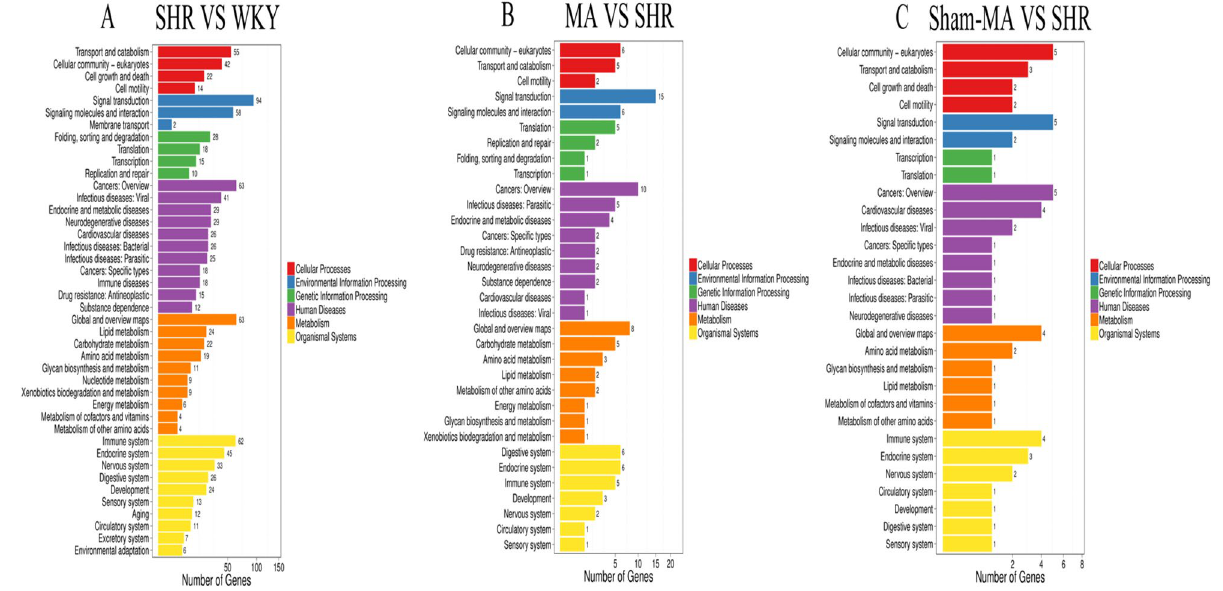
Figure 6. The KEGG Pathway functional enrichment results for the DEGs between WKY, SHR, MA and Sham-MA. With DEGs, KEGG pathway classification and functional enrichment were performed. ( A ) SHR versus WKY; ( B ) MA versus SHR; ( C ) Sham-MA versus SHR. KEGG analyses were performed using enrichment analysis with the phyper function in R version 3.6.0 (https:// cran.r- proje ct. org/ bin/ windo ws/ base/ old/3. 6.0/).